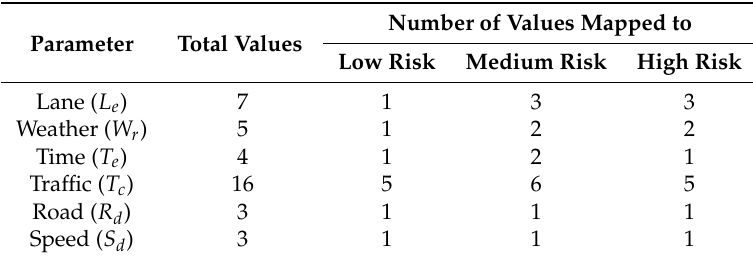
Table 4. Vehicle context parameters